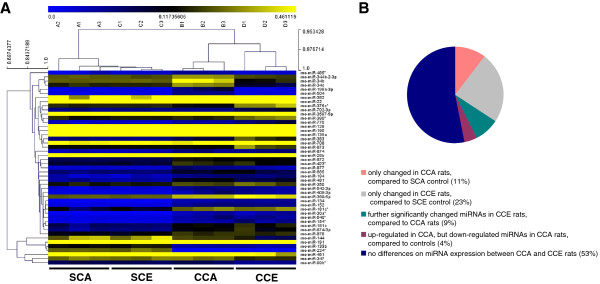
Comparison of miRNA expression in hippocampus between CCA and CCE rats. (A) Hierarchial-clustering map. Rows, individual miRNA; columns, individual sample. A1-3, B1-3, C1-3 and D1-3 are the sample numbers for each group. Values are normalized median. n = 3 samples/12 rats per group. (B) Comparison of the miRNA expression patterns between CCA and CCE rats. Altered hippocampal miRNAs in this study are divided into 5 classes according to their expression patterns in CCA and CCE rats. The percentage of each class was shown in the pie-chart.